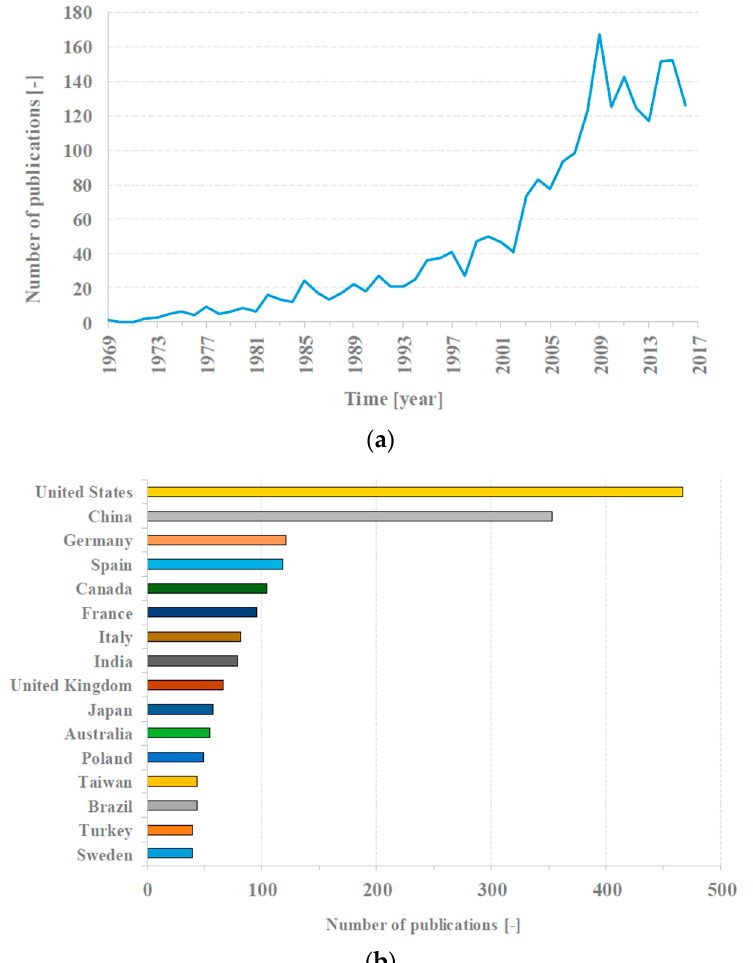
Figure 1. Trend of scientific production concerning treatment of wastewater contaminated by hydrocarbons over time ( a ) and worldwide ( b ) (Scopus ® —Copyright © 2017 Elsevier B.V).